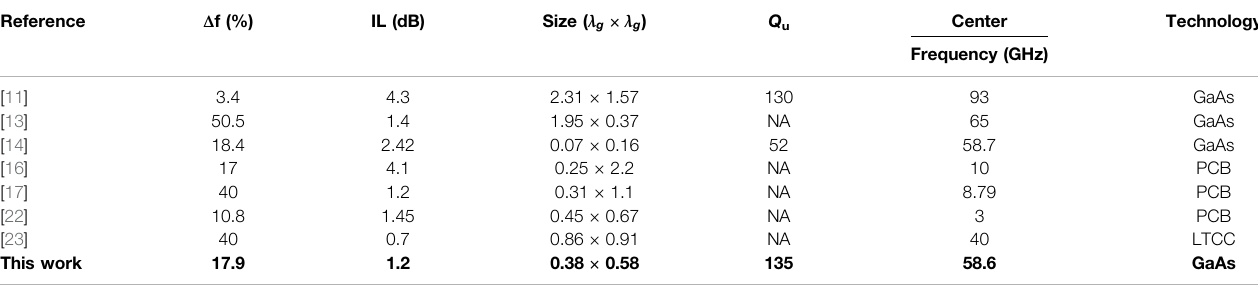
TABLE 2 | Performance comparisons with some reported SIW/HMSIW BPFs.